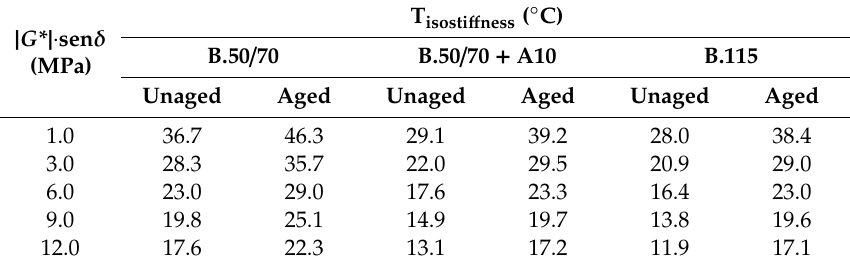
Figure 4. Typical isochrone test results. Table 3. Temperatures guarantying the iso-stiffness condition.